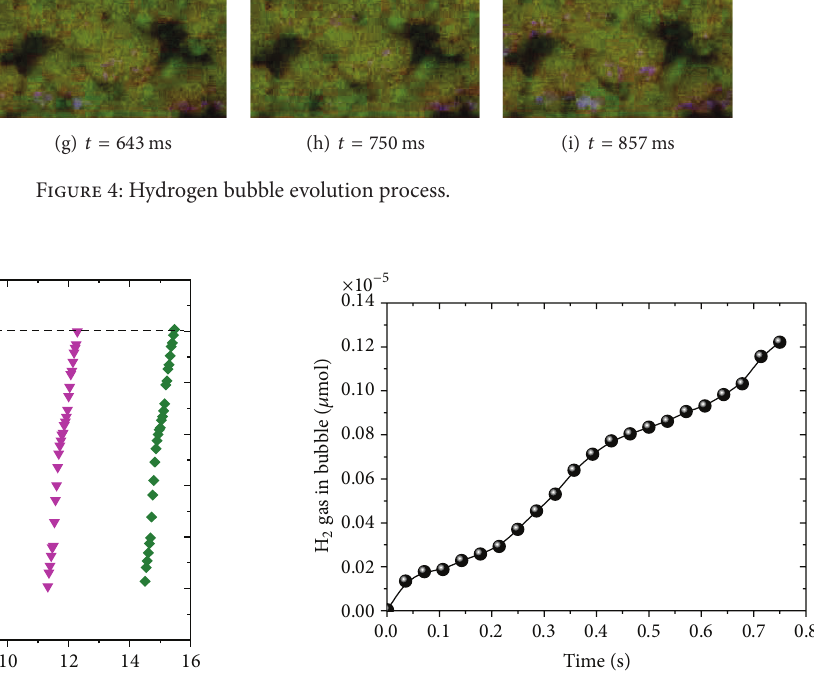
Figure 6: Calculated hydrogen evolution rate from gas